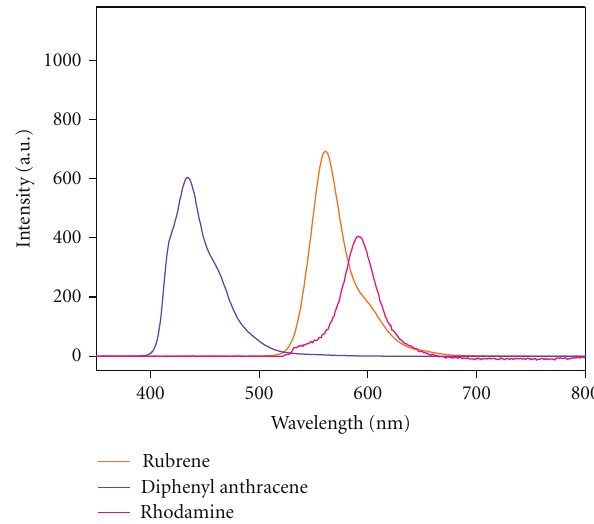
Figure 4: Chemiluminescence emission spectra of peroxalate ester oligomers and di ff erent dyes in dimethyl phthalate in the presence of H 2 O 2 .